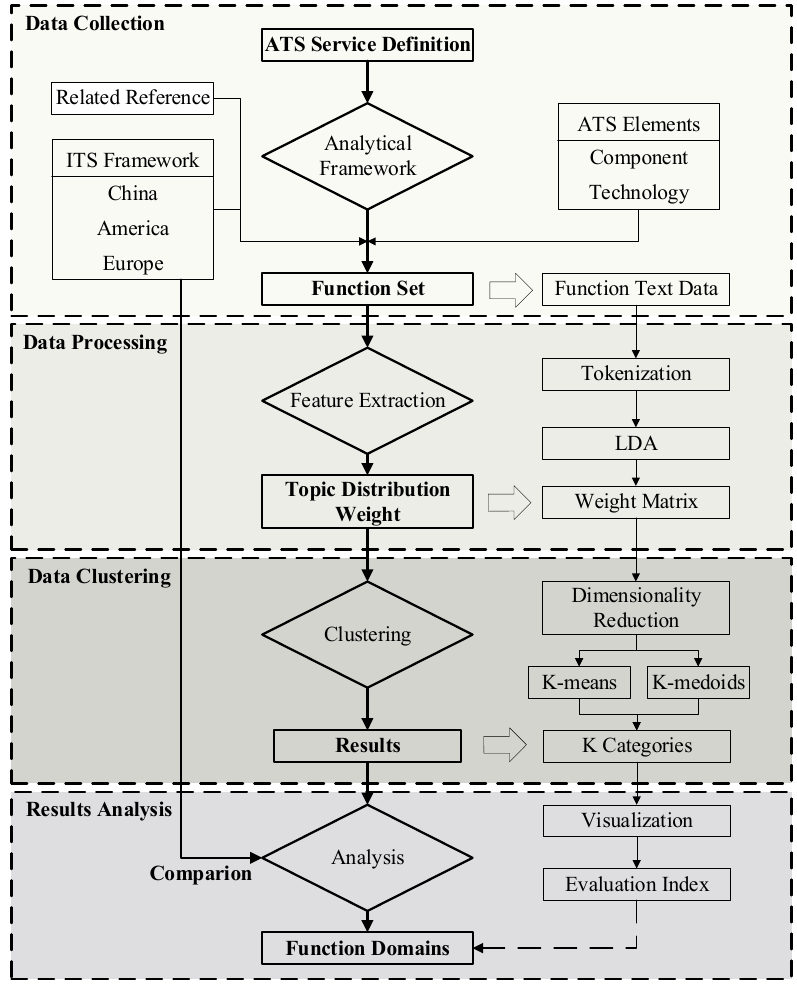
Figure 2. Flow chart of the study.